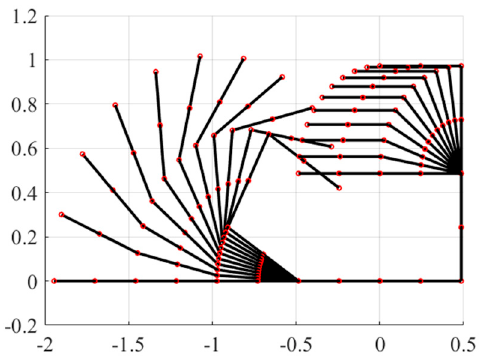
Figure 16. SMSRS reconfigure in linear joint paths in case 1.